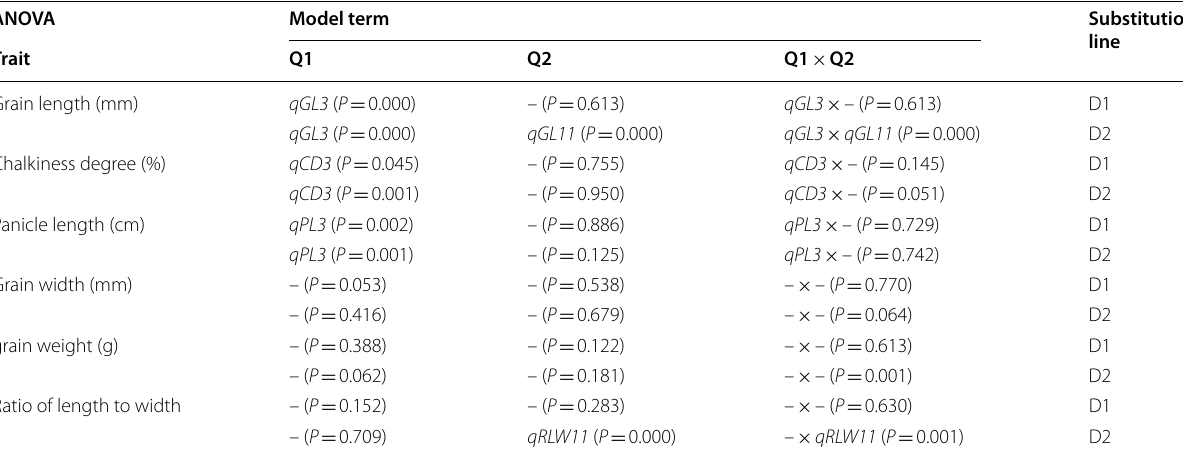
Table 2 Epistasis between QTLs in DSSL detection by two-way ANOVA